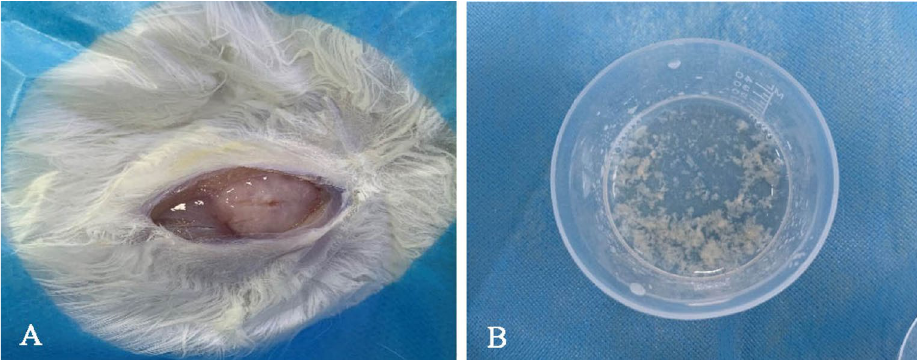
Figure 1. Preparation of VX2 tumor suspension. The tumor was removed from hind limb muscle of the rabbit ( A ); the VX2 tumor suspension was made ( B